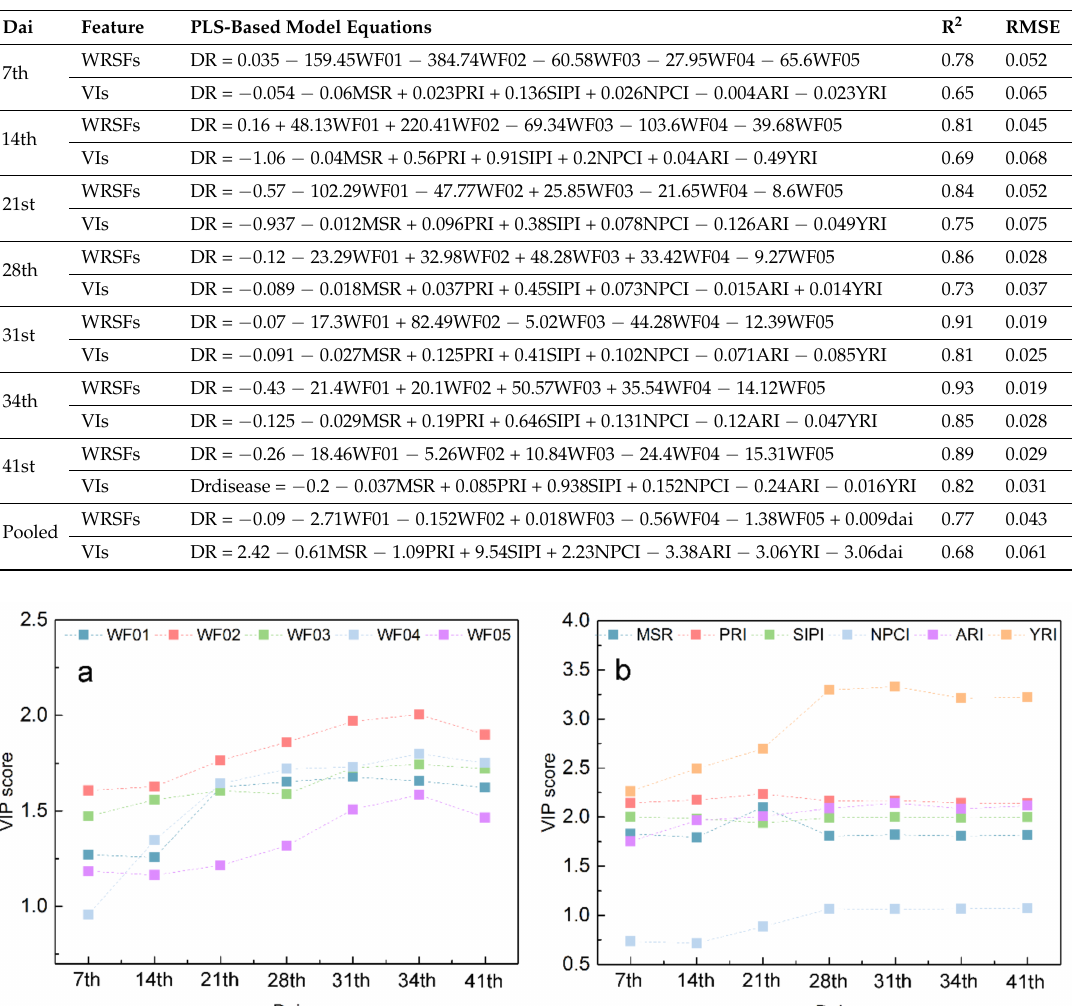
Table 6. Retrieving PLSR models and validation accuracies for DR estimation disease ratio (DR) estimation separately for each spectral index group (WRSFs and VI) and date after inoculation (dai).